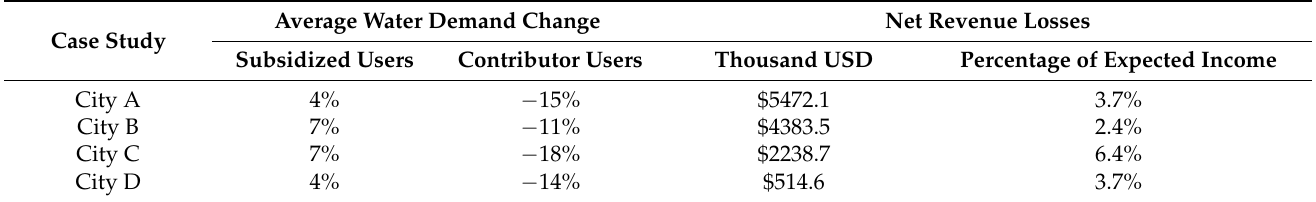
Table 4. Average water demand change for subsidized and contributor users, and the corresponding net revenue losses for water utilities in every case study. Subsidized users correspond to Strata 1, 2, and 3 domestic users, and contributors are commercial, industrial, public, and Strata 5 and 6 domestic